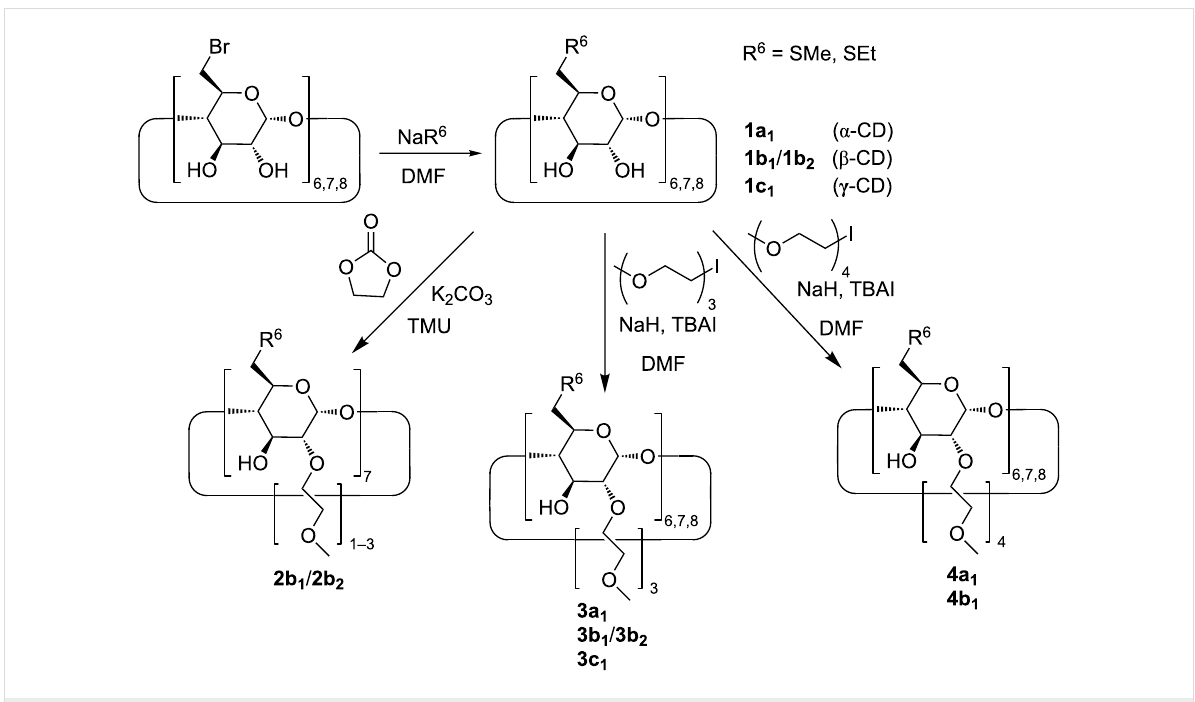
Scheme 1: Synthetic route to neutral water-soluble CD